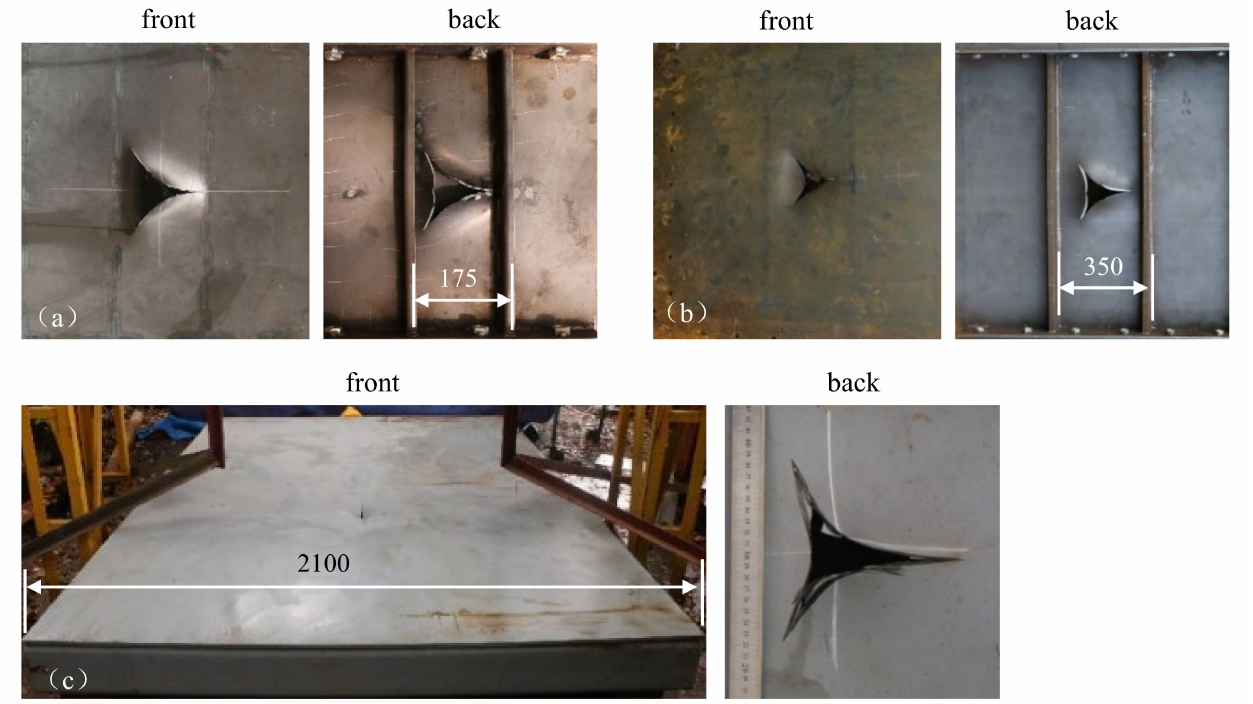
Figure 8. Damage mode of the three specimens in the impact test (unit: mm): ( a ) 1:4 scaled; ( b ) 1:2 scaled; ( c ) full-scaled.